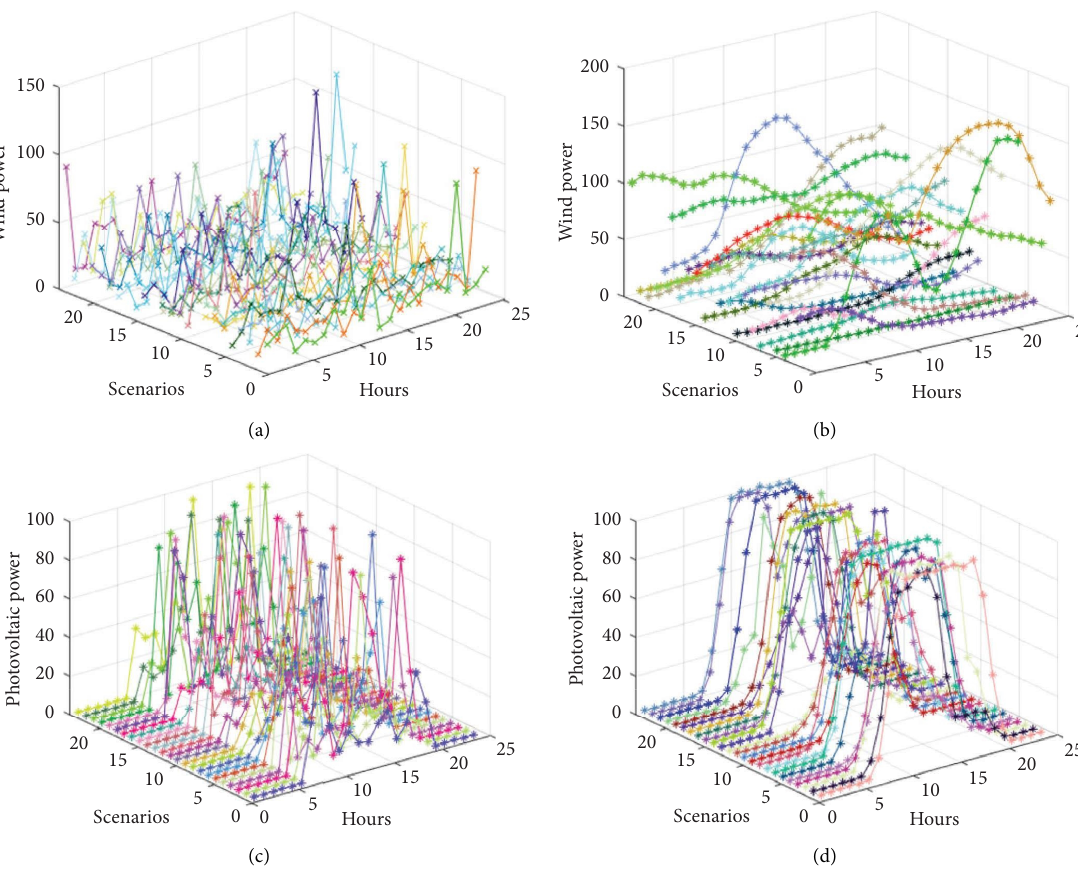
Figure 6: Wind-photovoltaic scenarios based on probabilistic model or time. (a) Wind power scenario based on probability model. (b) Time series-based wind power scenario. (c) PV power scenario based on probabilistic model. (d) Time series-based PV power scenario.